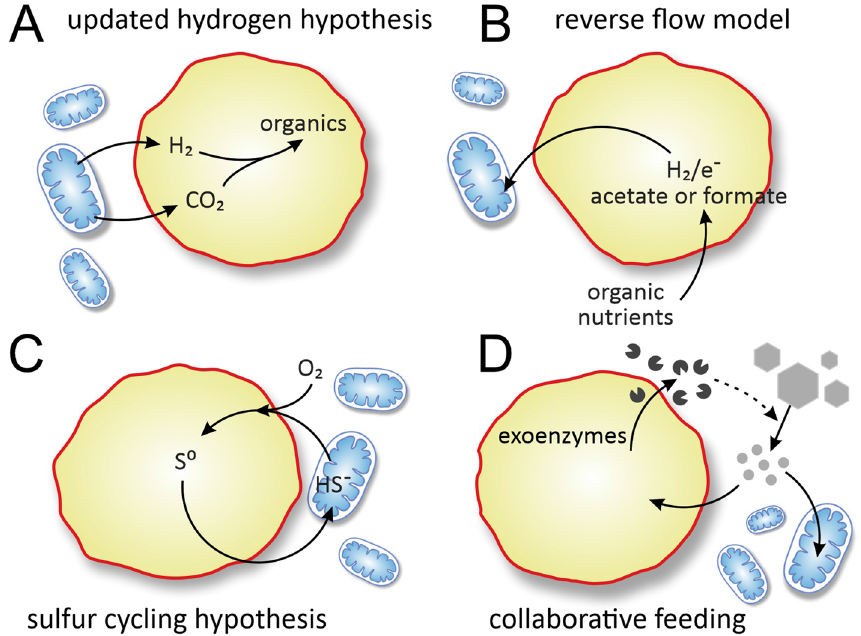
Figure 6. Comparison of various syntrophic eukaryogenetic hypotheses. The updated hydrogen hypothesis 68 ( A ) and the reverse flow hypothesis 69 ( B ) are examples of unidirectional (flow-through) byproduct consumption. The sulphur cycling hypothesis 78 ( C ) is an example of symmetric recycle-type cross-feeding. ( D ) The collaborative-feeding model envisages a partner that secretes external enzymes that catalytically benefit both itself and any partner through making resources available to feed on (a case of cross-facilitation). The image is based on the image of 71 (where a third partner is postulated, ignored in our